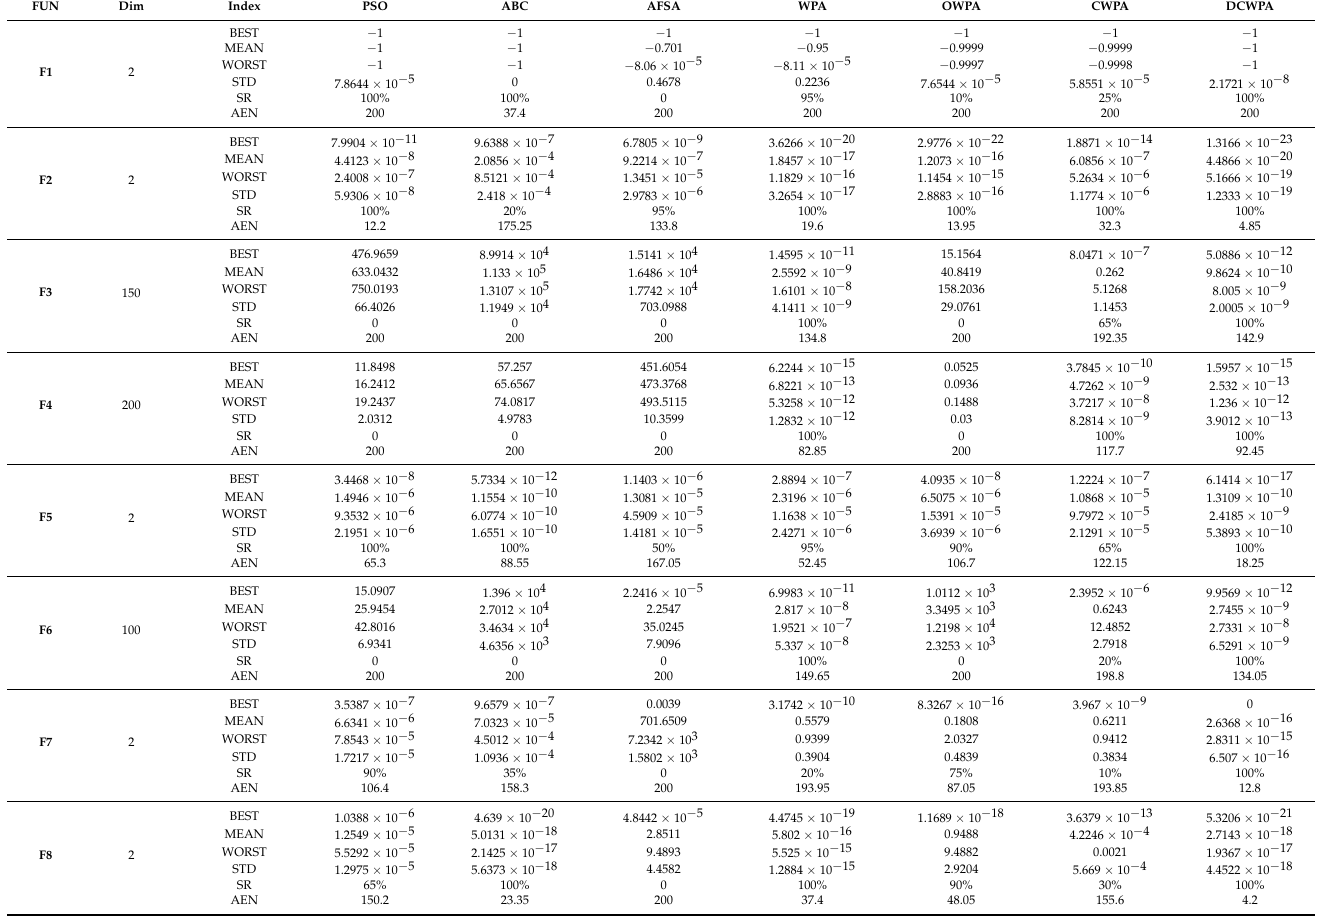
Table 5. Comparison of test results of the intelligent optimization